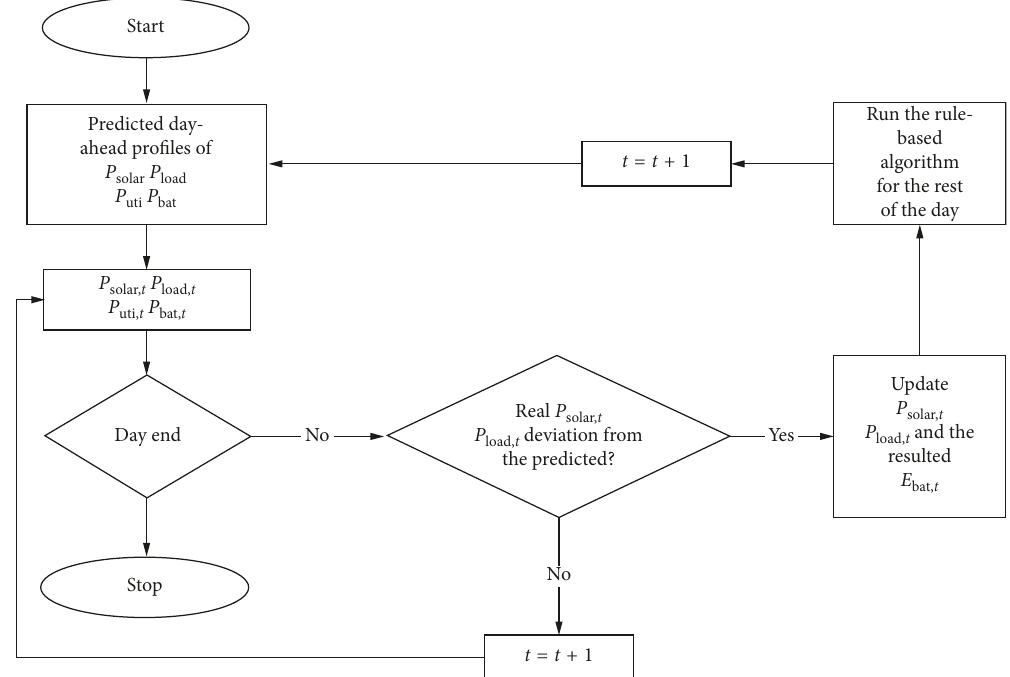
Figure 4: Algorithm for power source intraday schedule